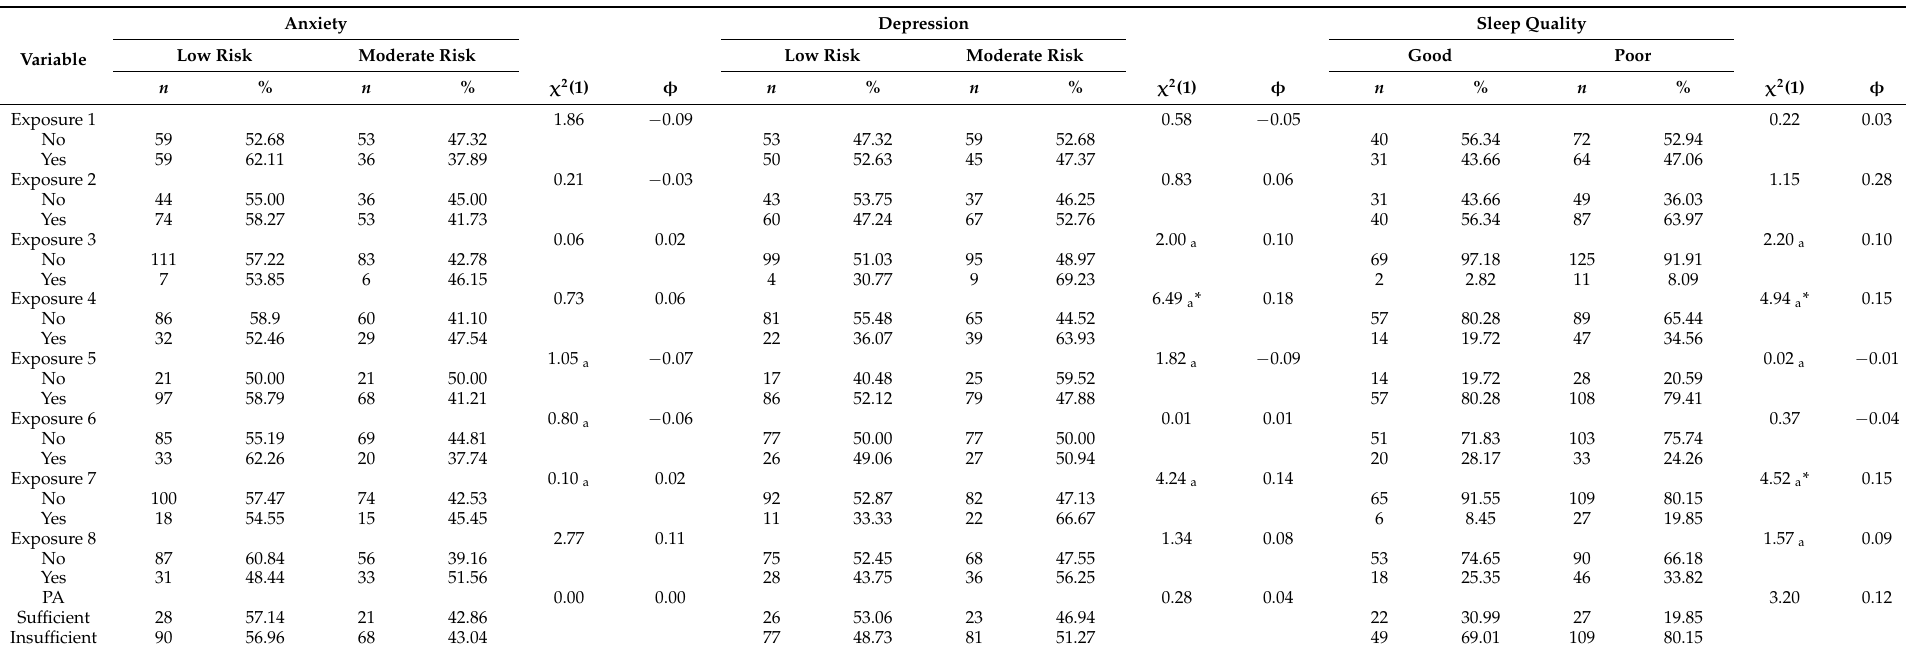
Table 2. The associations of anxiety and depression with exposure to COVID-19 and physical activity N =